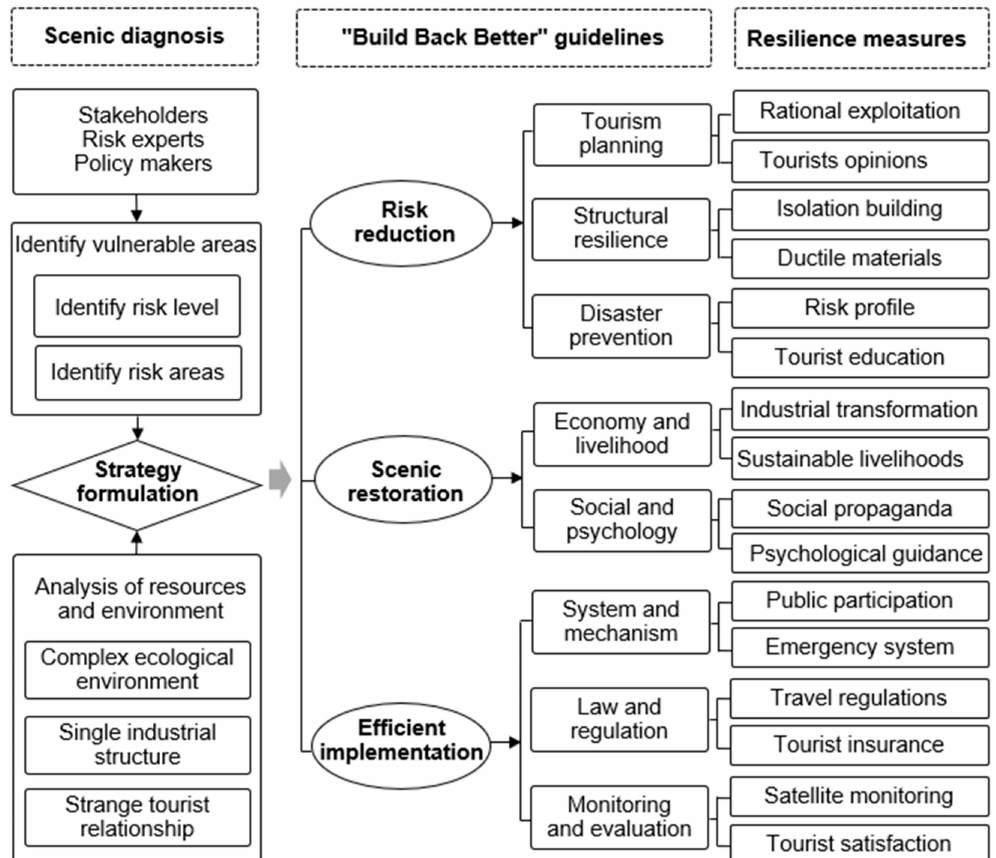
Figure 5. The basic framework of resilience development of scenic spots post-disaster under the concept of “Build Back